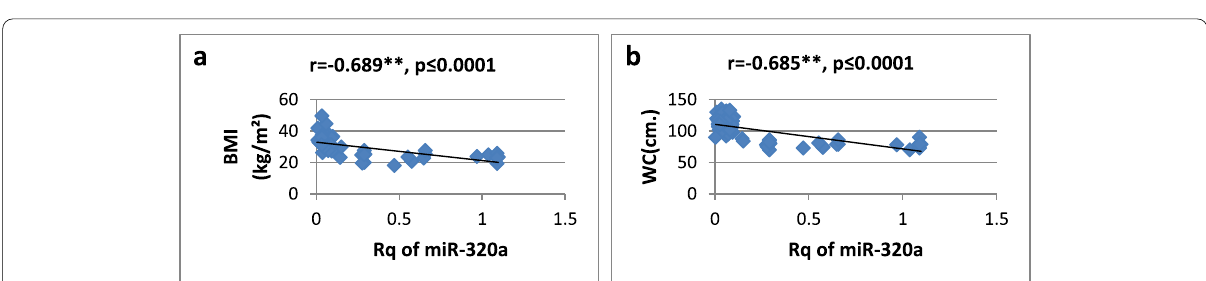
Fig. 6 a , b Correlation coefficient between Rq of MicroRNA 27‑a and both TG ( r significant at p 0.0001 ≤